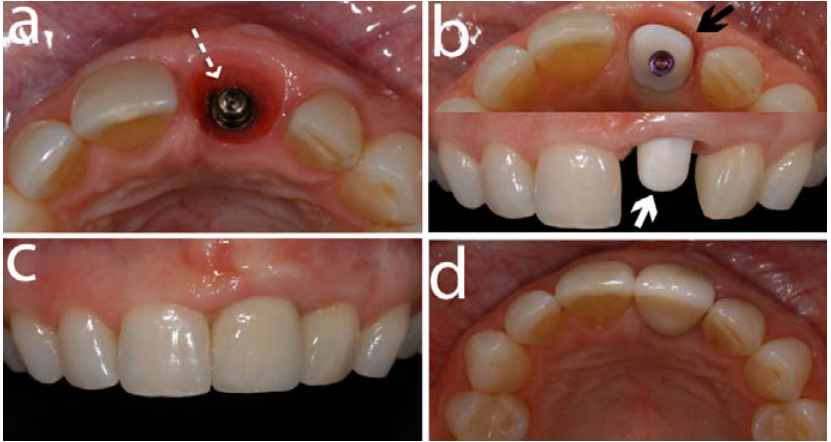
Switzerland) placed (a) in a left central incisor area (segmented white arrow). (b) illustrates the occlusal view (black solid arrow) and front view (white solid arrow) of a zirconia abutment (Cares Abutment, Straumann, Basel, Switzerland) screw-retained on the implant. (c) and (d) are front and occlusal views respectively of the final restoration cemented on the